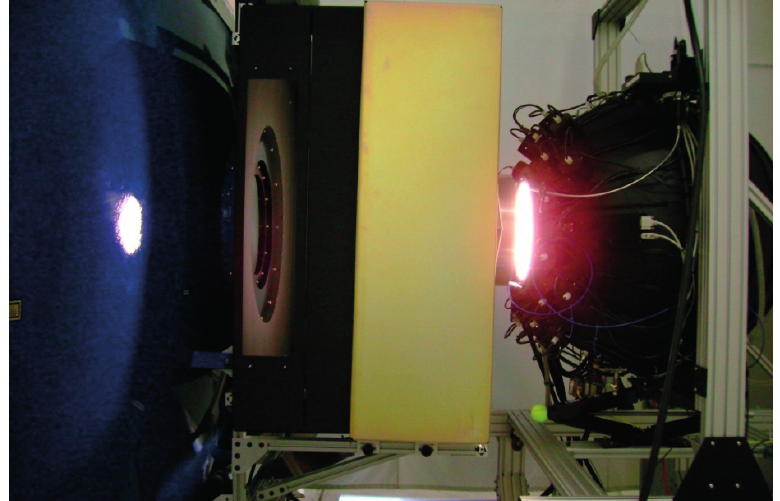
Figure 11. The large integrating sphere used to characterize the instrument’s radiometric